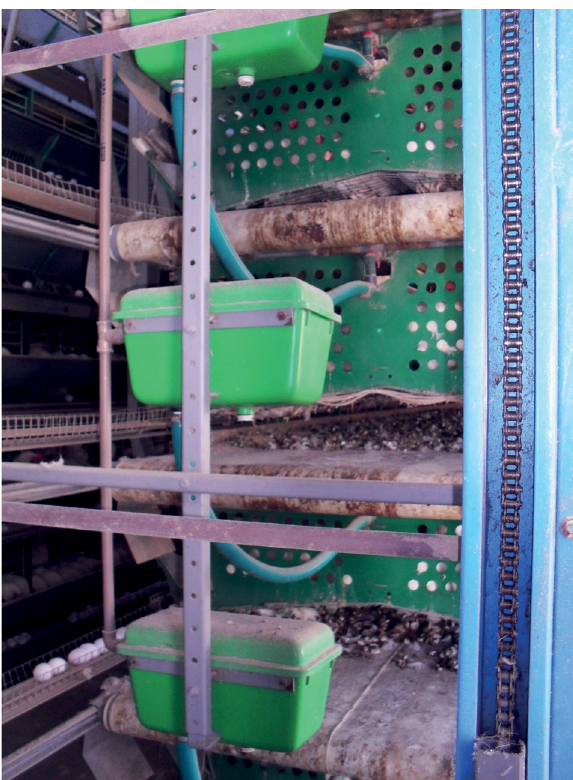
Figure 3. Poultry houses with presence of lesser mealworm (Coleoptera: Tenebrionidae), Alphitobius diaperinus